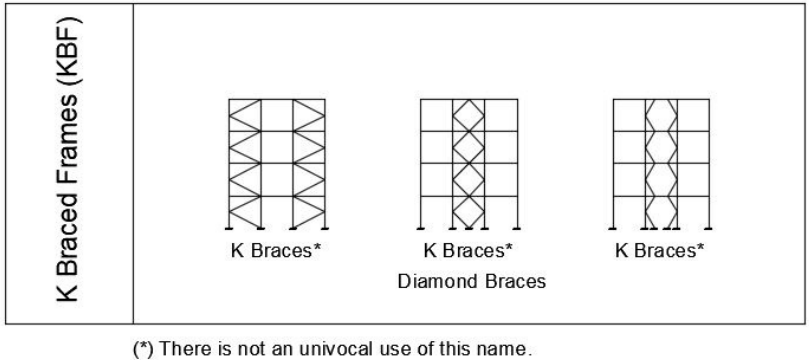
Figure 13. Nomenclature for the main types of K braced frames.